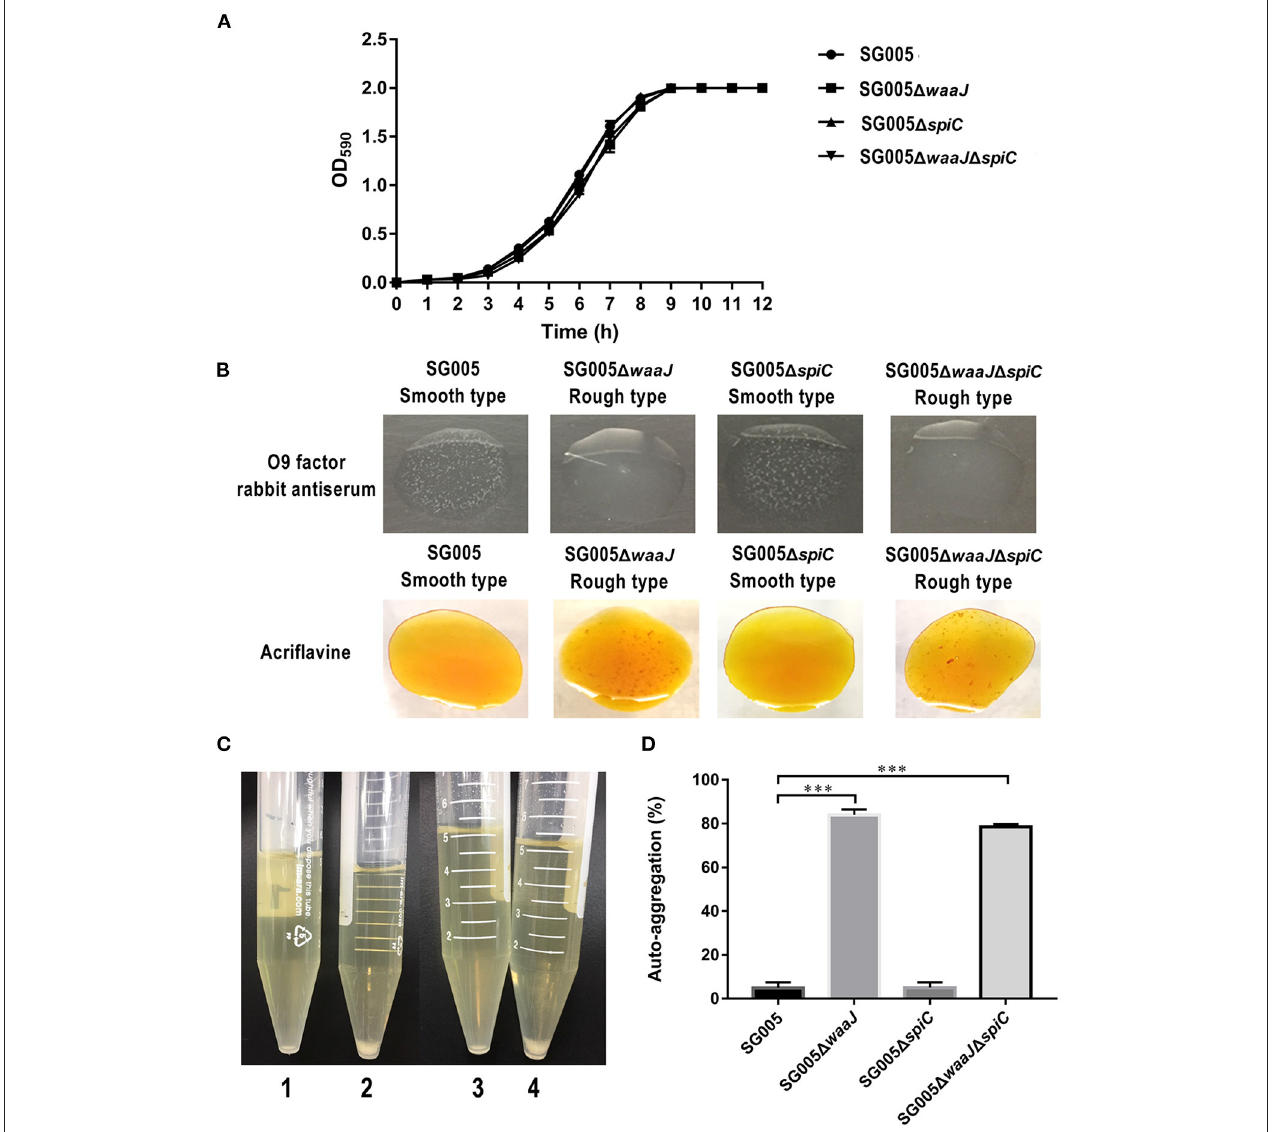
FIGURE 1 | Growth curves, phenotypic characterization, and auto-aggregation assay. (A) Growth curves of wild-type SG005 and the deletion strains. SG005, SG005 1 waaJ , SG005 1 spiC , and SG005 1 waaJ 1 spiC showed a similar growth curve in LB broth. (B) Phenotype identification. Agglutination was examined with O9 factor rabbit antiserum and acriflavine. Pictures were taken within 3min. (C) Visual auto-aggregation of SG005 (1), SG005 1 waaJ (2), SG005 1 spiC (3), and SG005 1 waaJ 1 spiC (4). (D) Auto-aggregation (%). Bacterial cultures were statically grown in LB broth for 24h at 37 ◦ C. Statistical analysis was done using one-way ANOVA. *** P < 0.001. Each experiment was repeated three